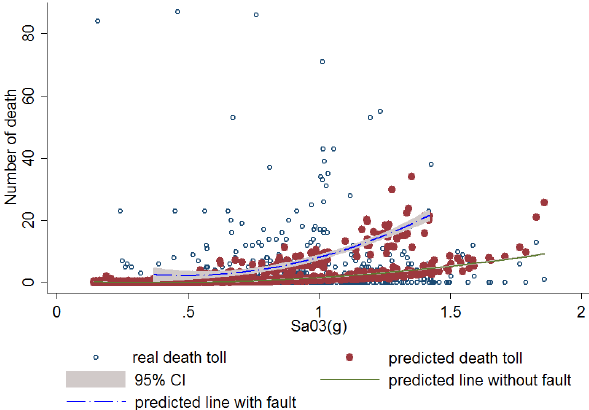
Figure 3. Causality among Sa03, Chelungpu fault and fatality in the 1999 Chi-Chi Earthquake. Note: red spot refers to the estimated fatalities (Model 3). Two curves refer to the fitted exponential rela- tionship between Sa03( g ) and the estimated number of deaths with fault impact (blue dashed curve) and without fault (brown curve). Blue hollow spot refers to the real death toll, around which 41.4% can be explained by the